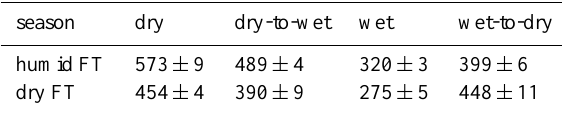
Table 3. Total particle number concentrations at Pico Espejo for different seasons and air mass types. The table indicates mean val- ues and one standard deviation of the mean in cm − 3 . Total